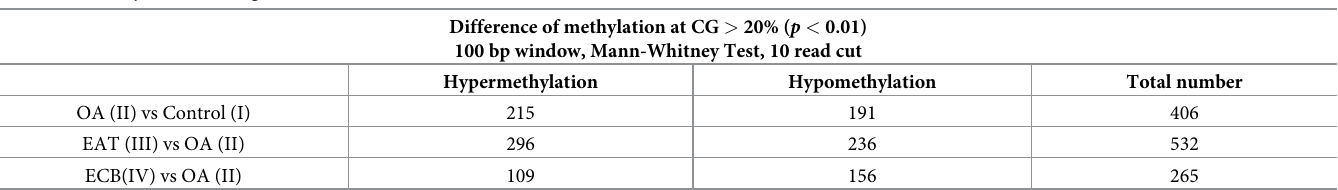
Table 2. Summary of selected significant DMRs.